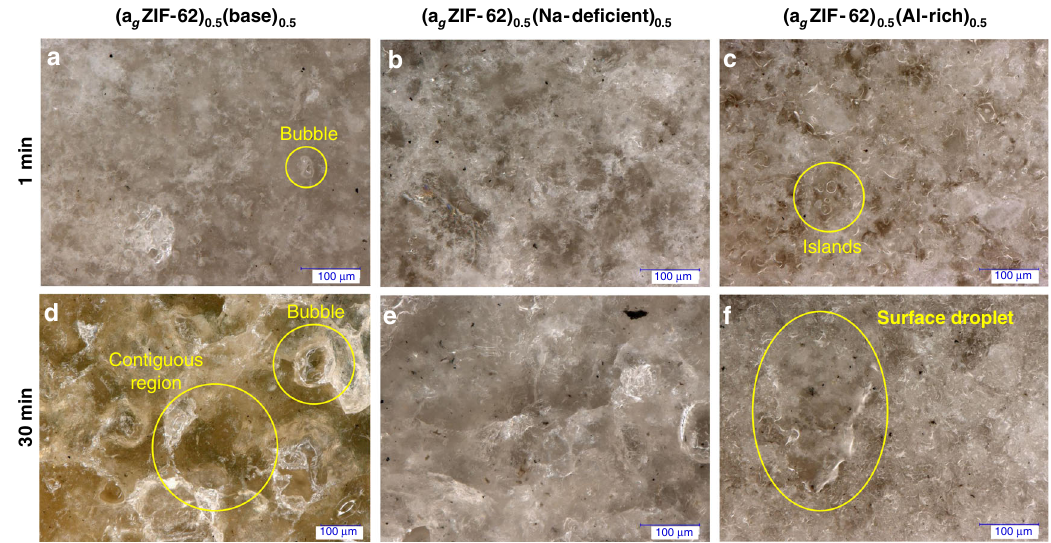
Fig. 3 Glass fl ow. Side-illuminated z -scan digital microscopy images of the (a g ZIF-62) 0.5 (Inorganic Glass) 0.5 compositions heat treated for 1 minute a – c and 30 minutes d – f .